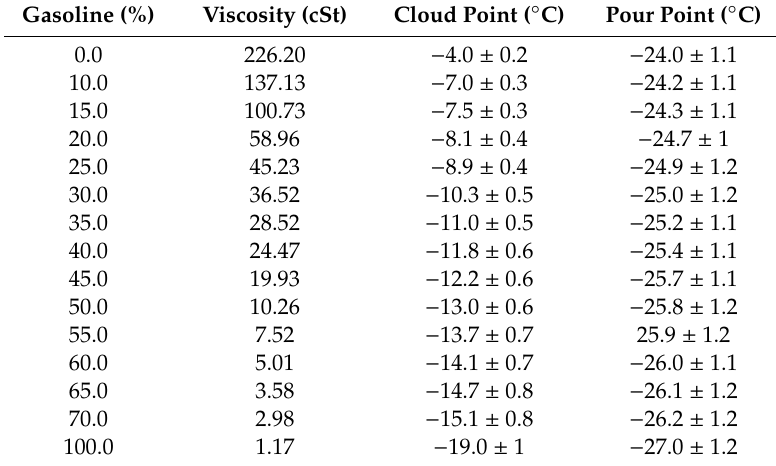
Table 2. Viscosity at 40 ◦ C (ASTM D2270-79), cloud point and pour point values of the gasoline / castor oil blends. Errors are always calculated as the average of three